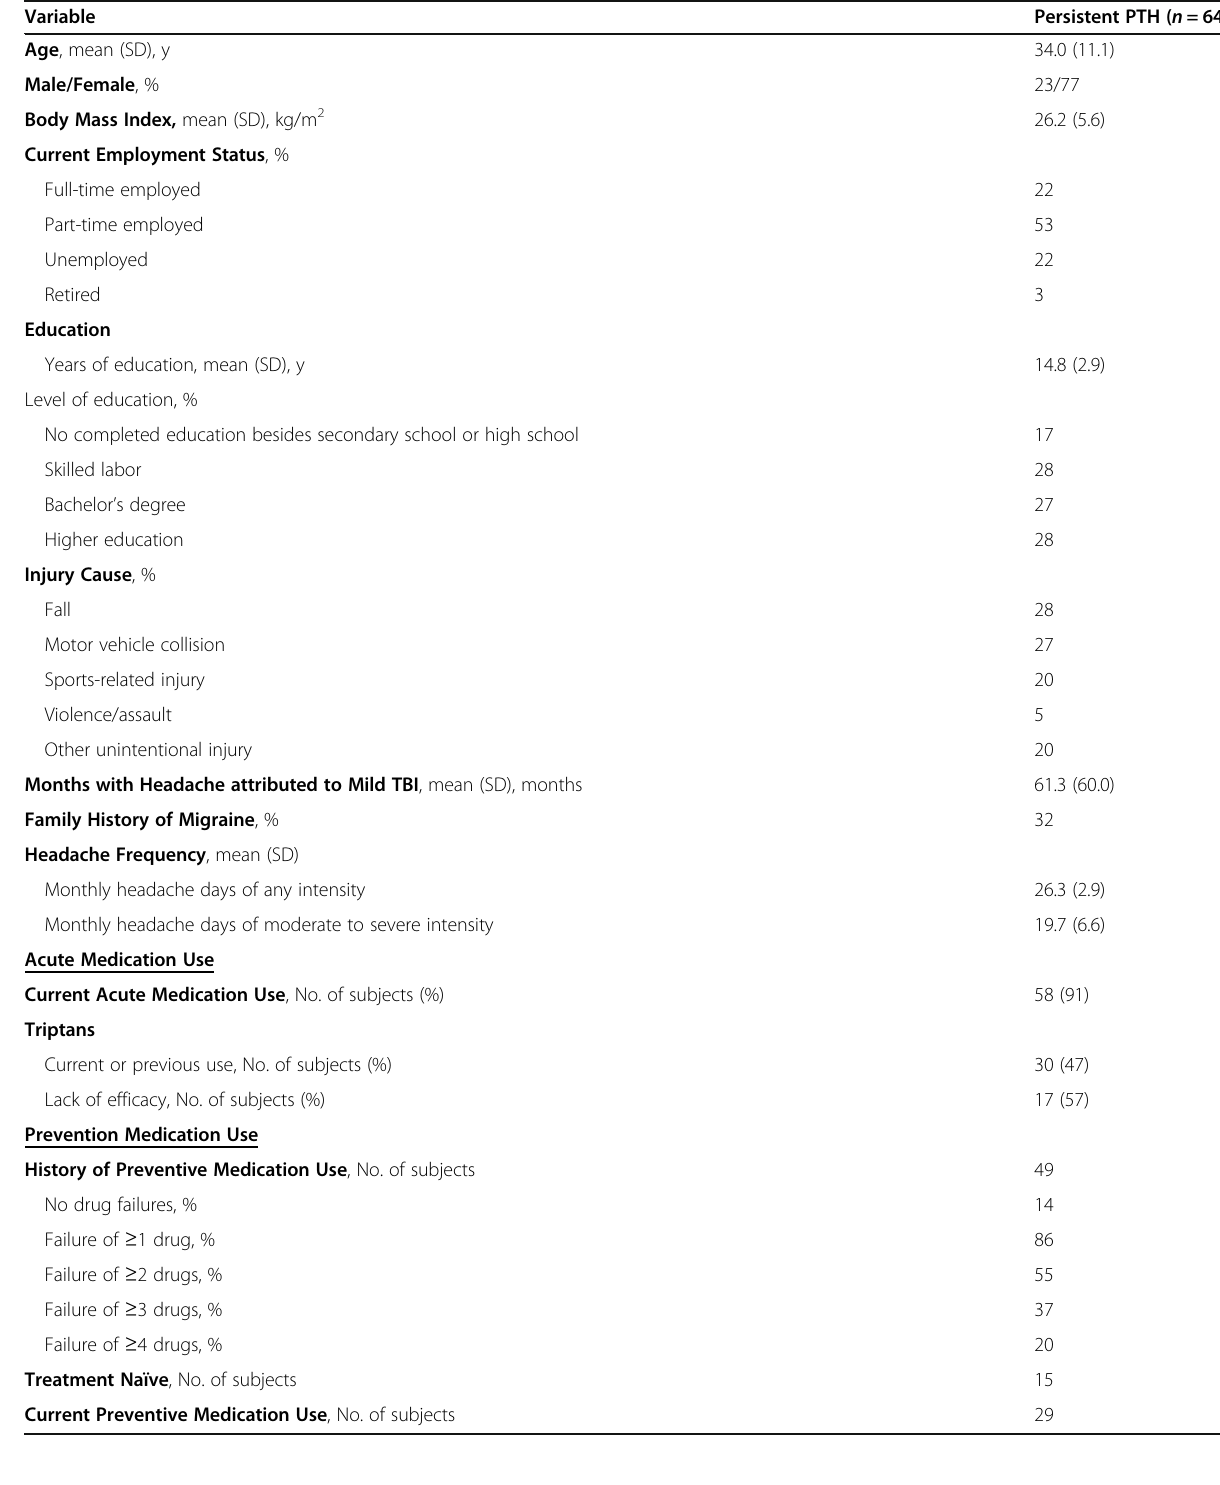
Table 1 Characteristics of the Study